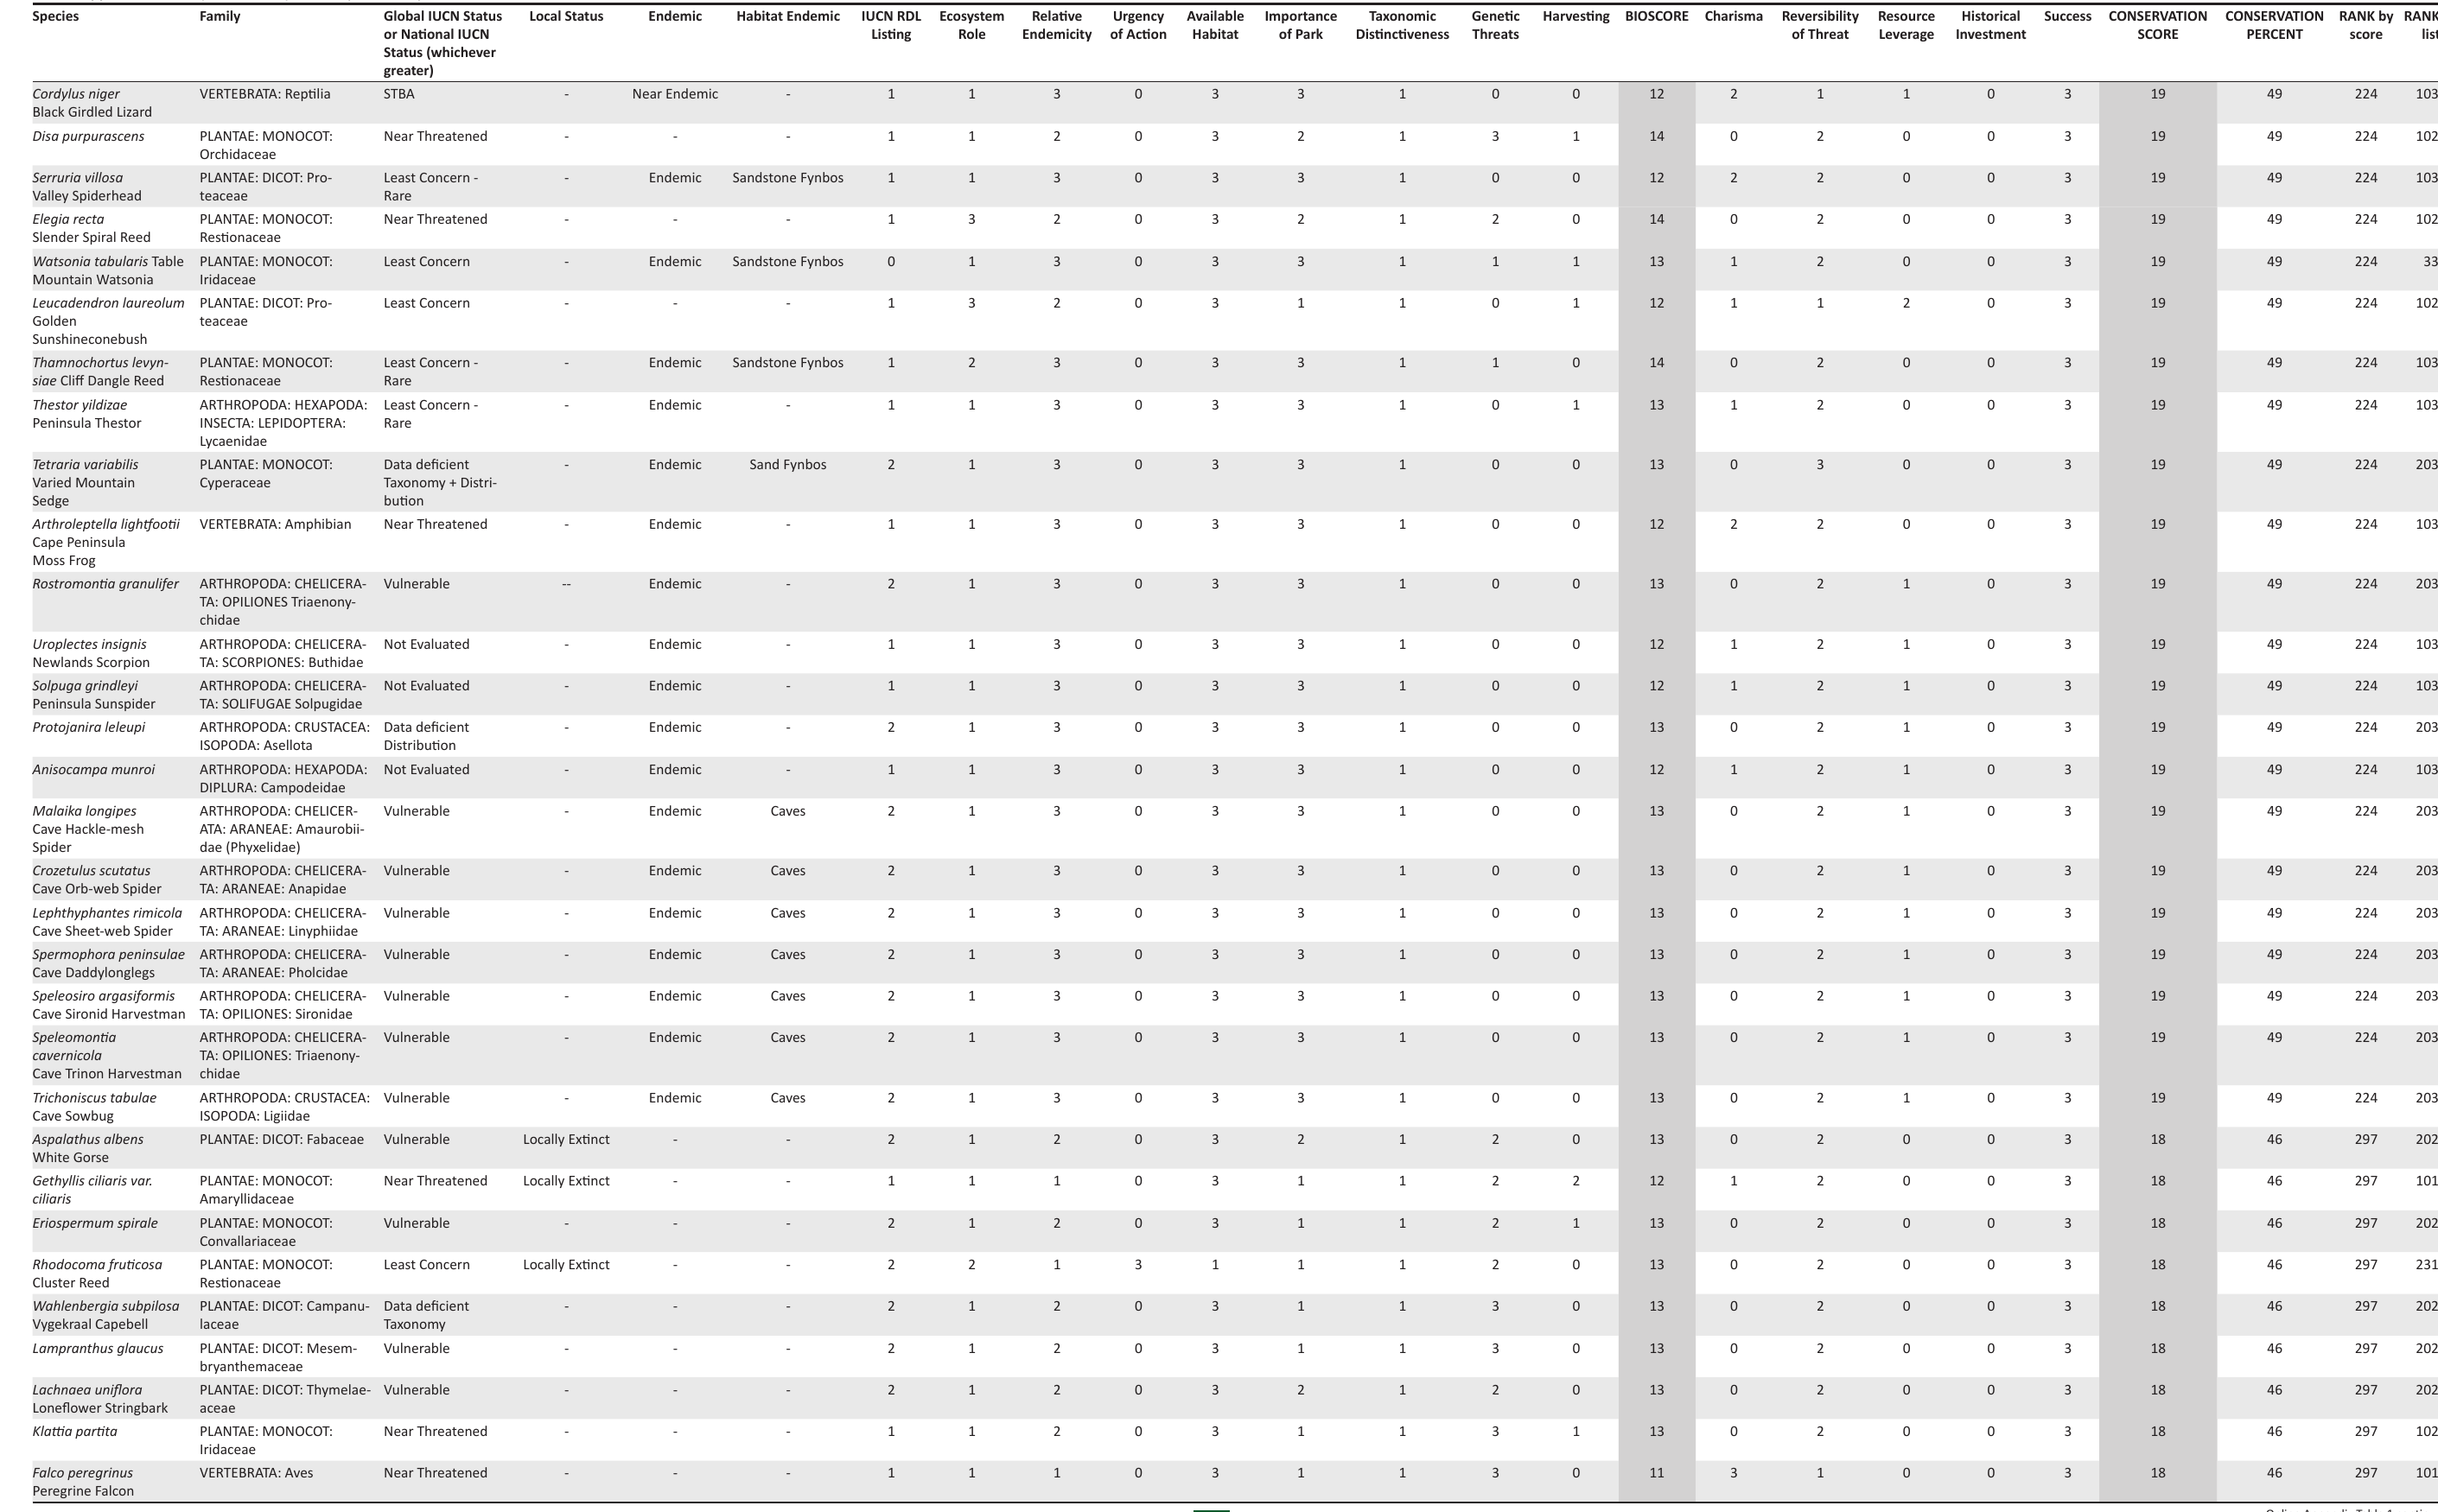
Online Appendix Table 1 (Continues...): List of species of Special Concern in the Table Mountain National Park and associated scores